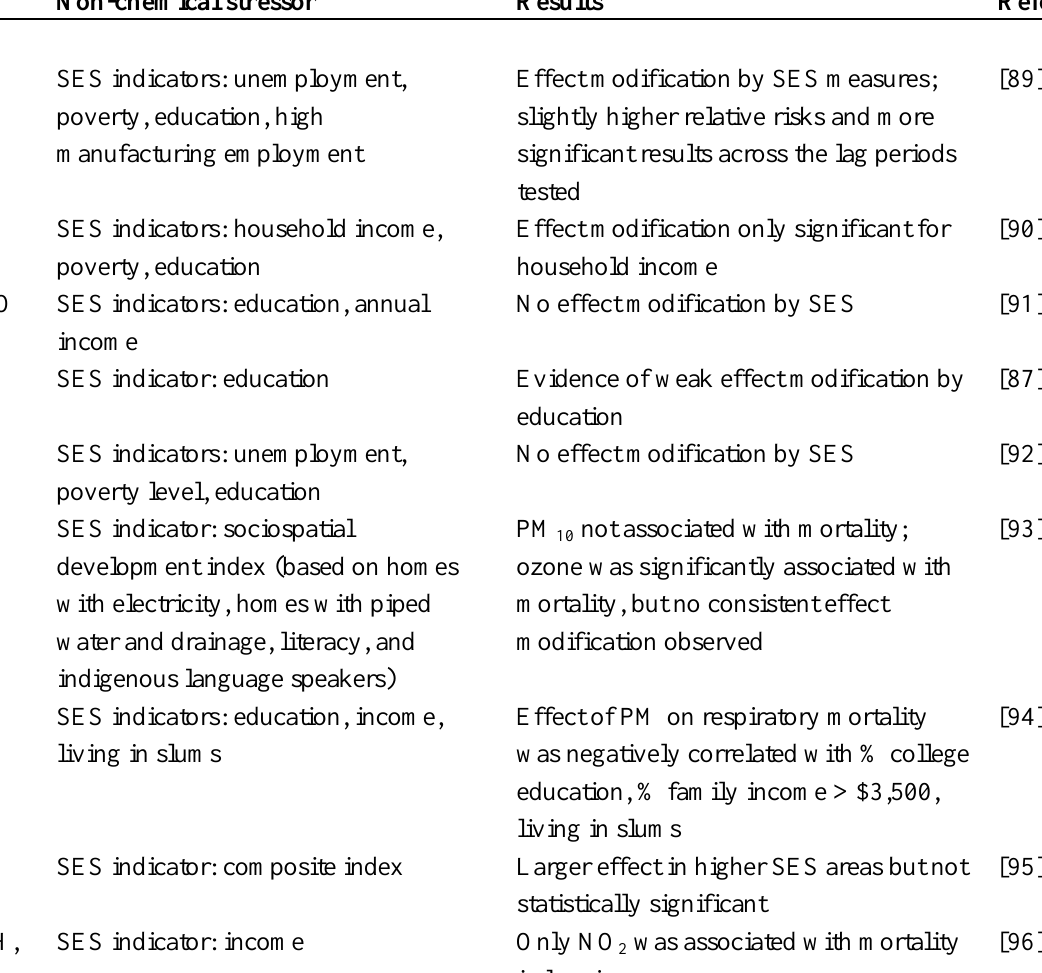
Table 4. Studies of effect modification of social stresses on chemical health